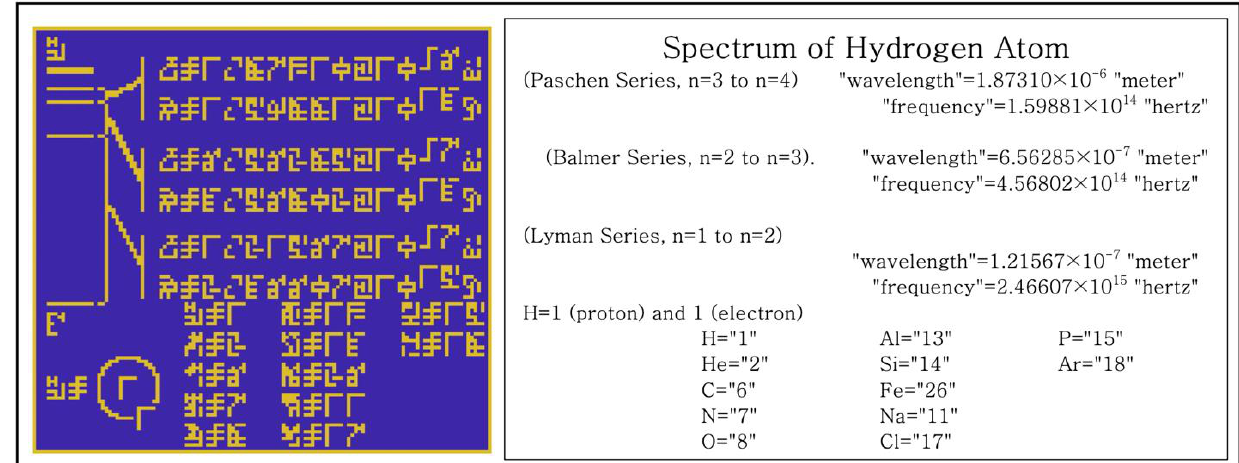
18 of 31 Figure 11. Hydrogen spectrum and hydrogen atom spin-flip transition in message, Page 5.